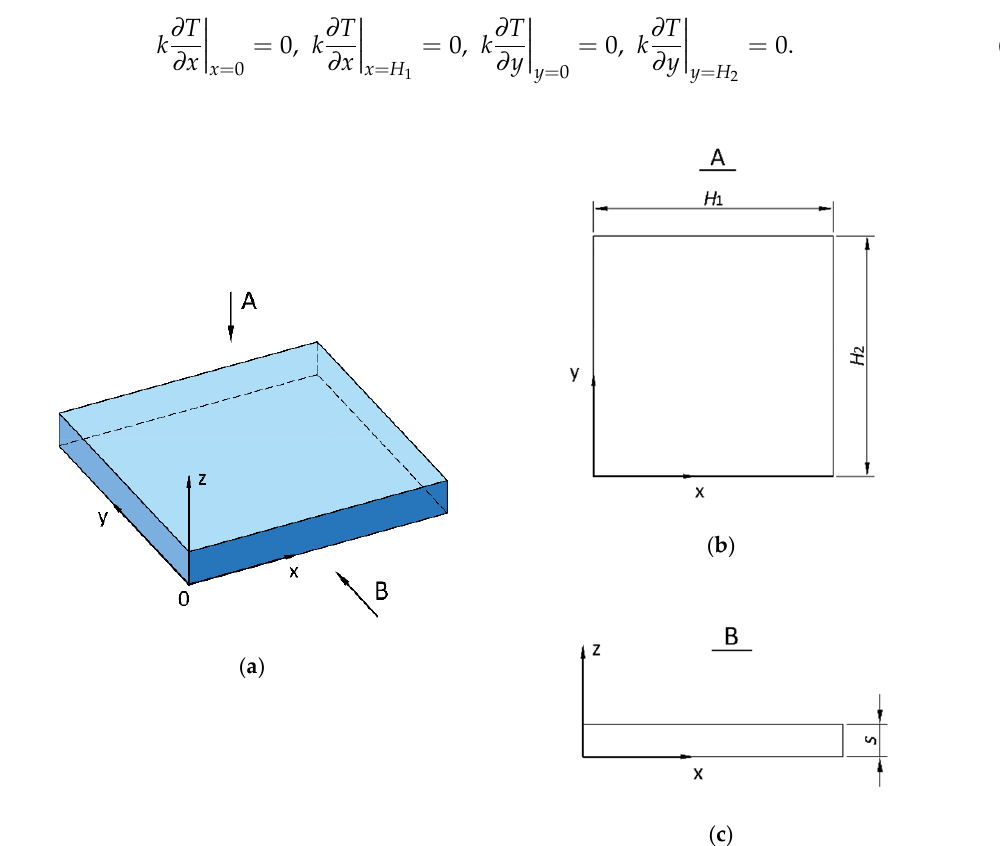
Figure 1. External dimensions of the flat plate and indication of the start of the coordinate system: ( a ) general view, ( b ) plate view from above, and ( c ) side view of the plate.